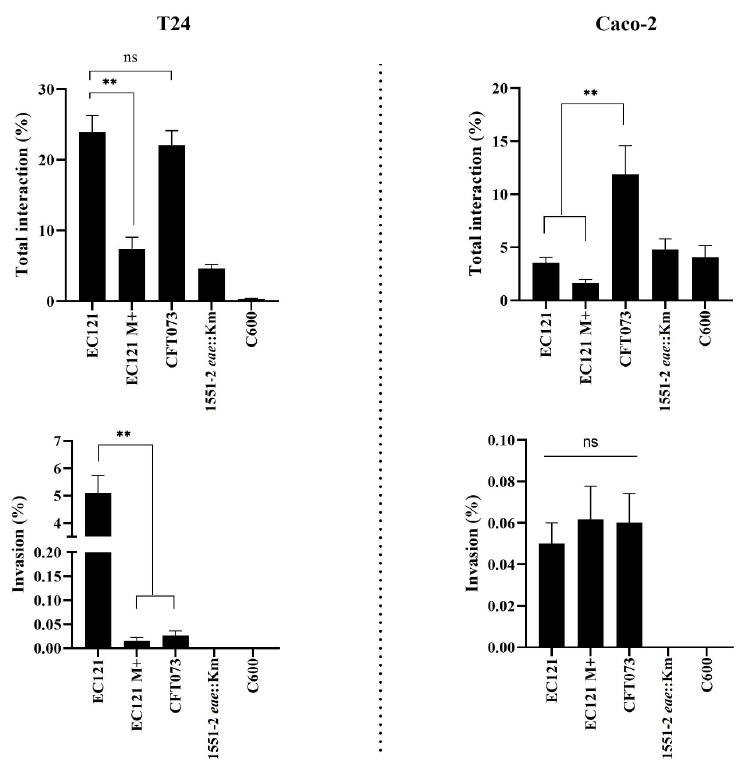
Figure 6. Interaction and invasion in different eukaryotic cell lineages. Short period quantitative invasion assay was performed in Caco-2 and T24 cells using a multiplicity of infection (MOI) of 50 in confluent cell cultures. All assays were carried out in the absence of D-mannose, except for EC121 M+, where 2% D-mannose was added in the assay medium; E. coli CFT073 was used as ExPEC control, E. albertti strain 1551-2 eae ::Km was used as an adherent noninvasive control, and E. coli C600 as was used as a noninvasive control. The assays were performed in experimental triplicates and biological duplicates. p values: ** < 0.01; ns > 0.05.